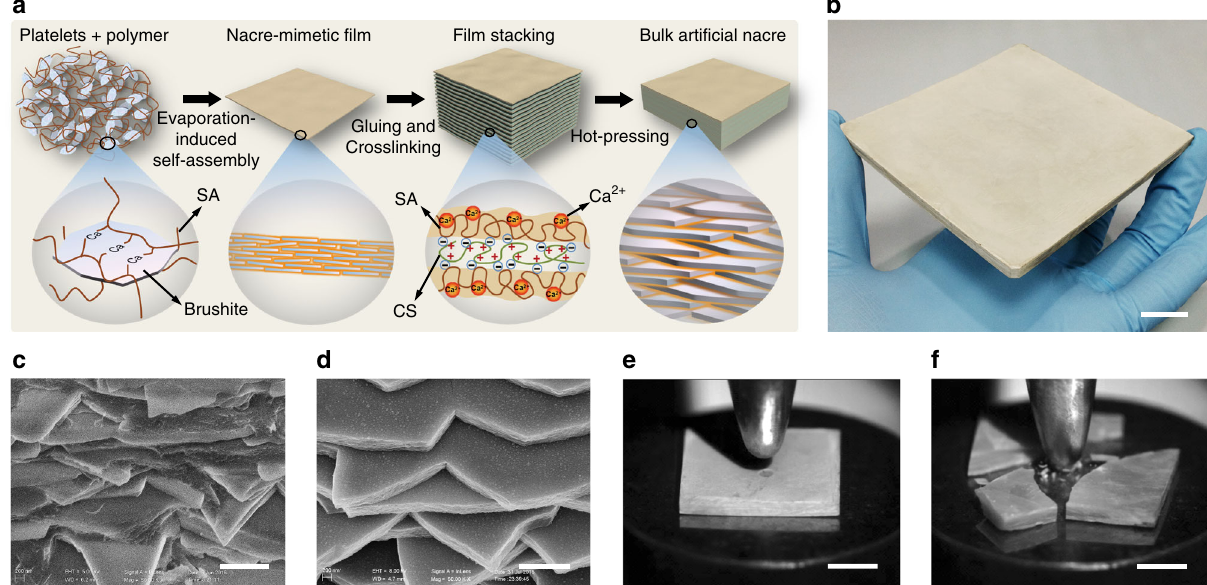
Fig. 1 Fabrication and characterization of bulk arti fi cial nacre. a Schematic illustration of the bottom-up assembly process of bulk arti fi cial nacre. b Large as- fabricated bulk arti fi cial nacre. Scale bar , 2 cm. c , d Cross-section of the arti fi cial nacre c and natural Cristaria plicata nacre d show the similar fractured layered microstructure. Scale bars , 1 μ m. e , f Arti fi cial nacre e and Cristaria plicata nacre f under the same strength of impact, illustrating the higher impact resistance of the arti fi cial nacre. Scale bars , 5